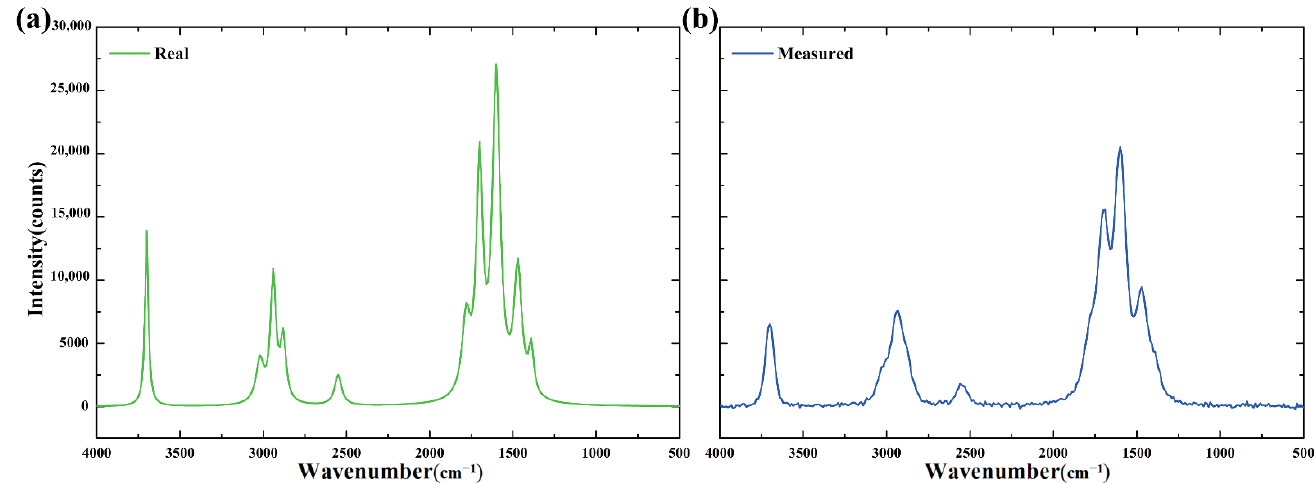
Figure 2. Simulated real and measured Raman spectrum. ( a ) Real Raman spectrum. ( b ) Measured Raman spectrum.